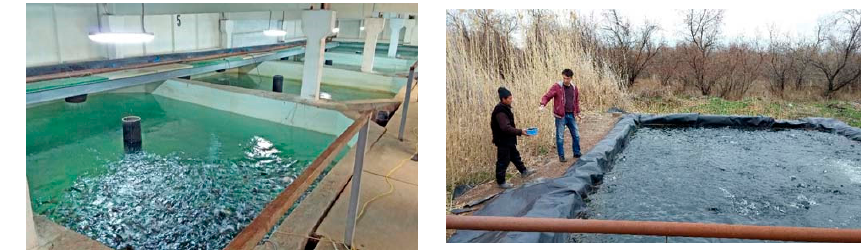
Figure 3. ( Left ) Interior fish tanks and ( Right ) outside ponds at the Chilik Pond Farm in 2016.